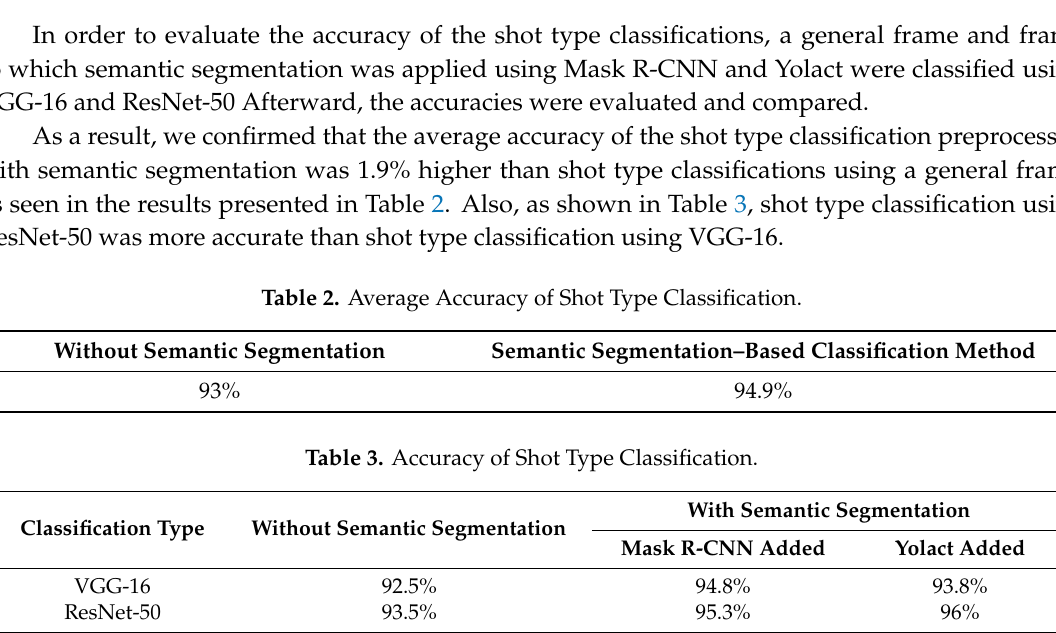
Table 2. Average Accuracy of Shot Type Classification.